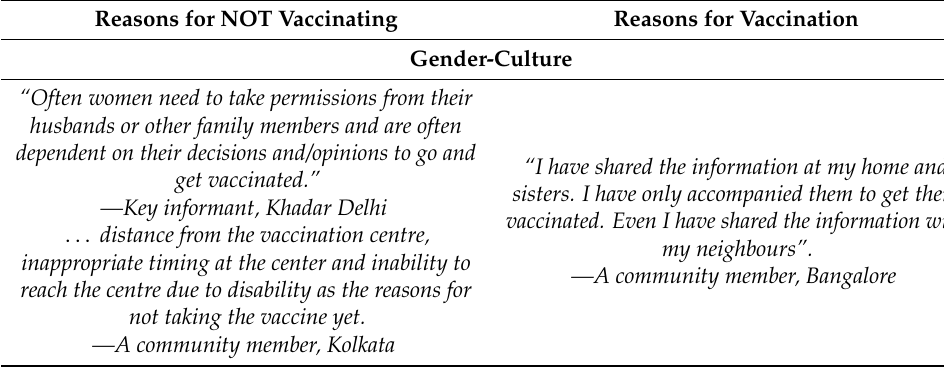
Table 8. Description of theme gender-culture with verbatim.